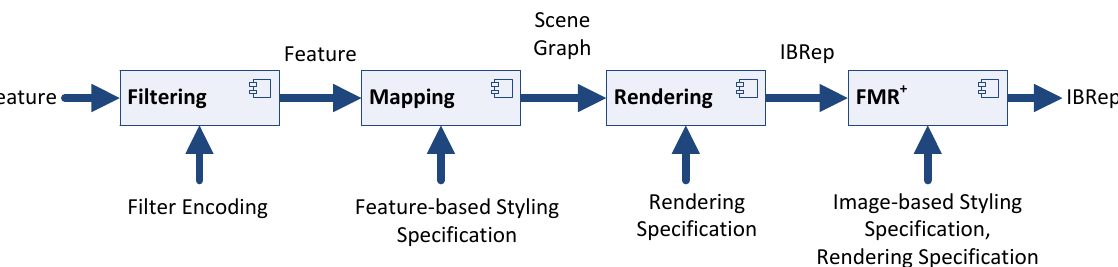
Figure 3. Example of a connected path of operators with defined stage specification types that transform input features into displayable output image-based representations